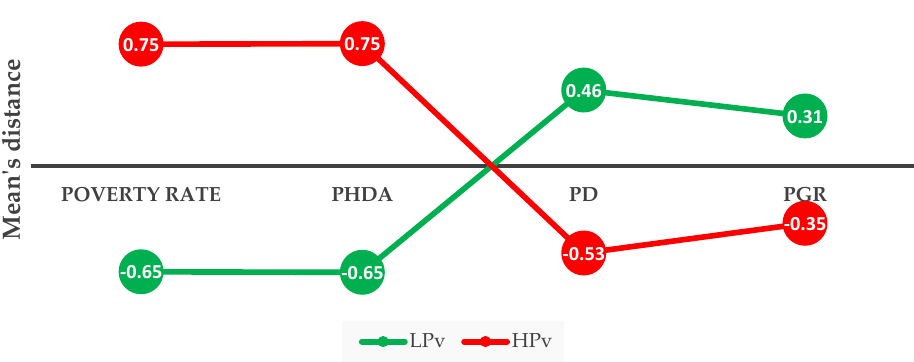
Figure 5. Mean of all members' values (after being standardized) of each variable for each cluster (LPv and HPv).